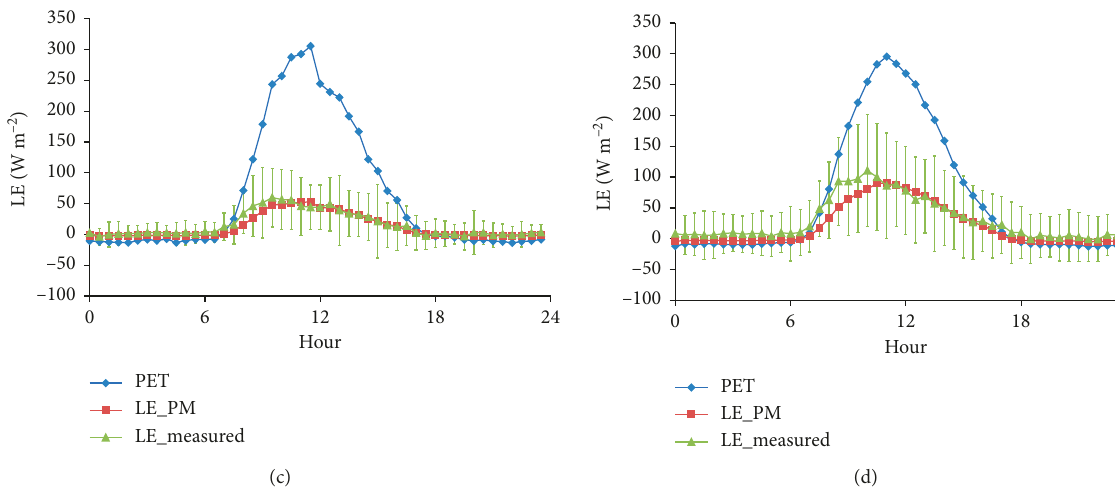
Figure 6: Comparisons between potential evapotranspiration (PET), predicted LE by PM equation (LE_PM), and measured LE (LE_measured) for the season of (a) warm 2005, (b) cool 2005, (c) warm 2006, and (d) cool 2006. The yellow box highlights the region where LE_measured is close to PET. The vertical bars indicate the standard deviations.